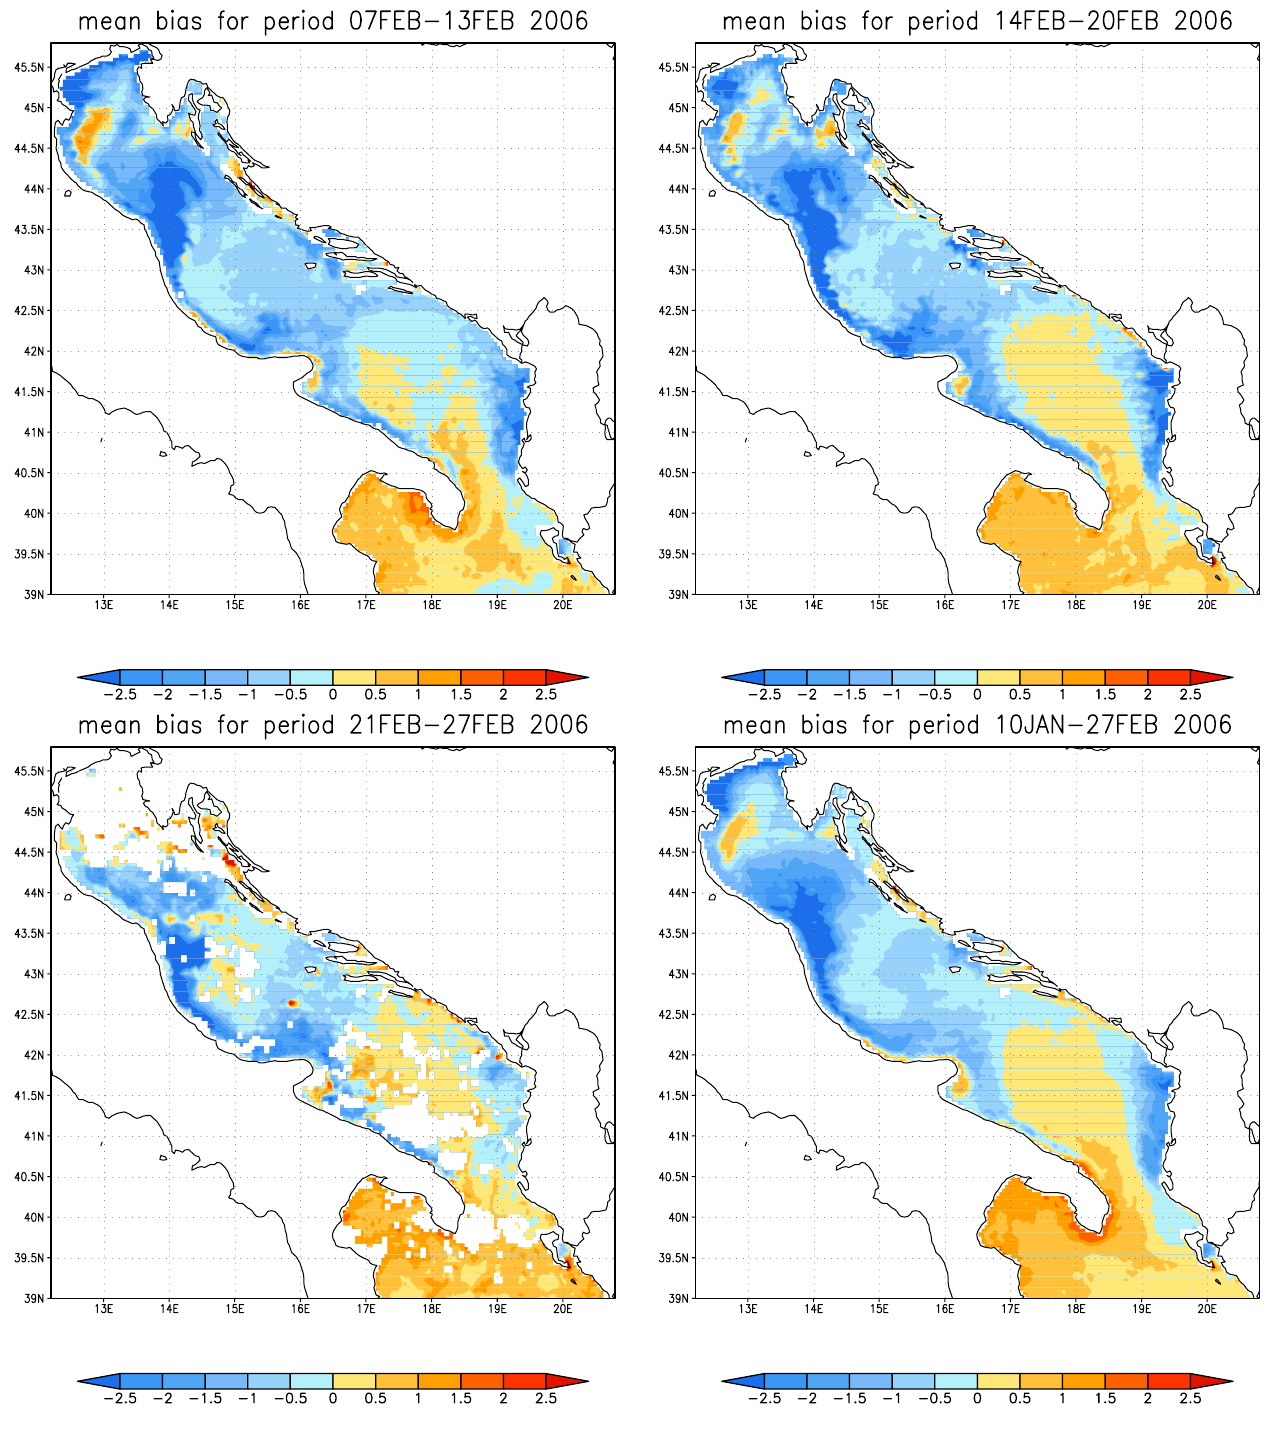
Fig. 6. Mean SST BIAS for three, seven-day periods 7–13, 14–20, 21–27 February and the entire period of 10 January–27 February over the Adriatic